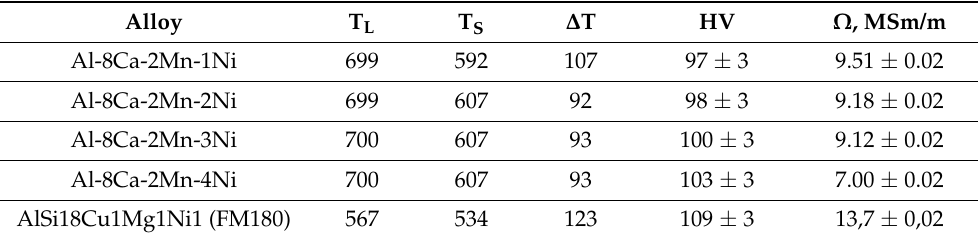
Figure 6. Calculated liquidus projection of the Al-Ca-Mn-Ni system at 8% Ca. Table 3. Calculated phase transformation temperatures, hardness and electrical conductivity of the as-cast Al-Ca-Mn-Ni alloys.